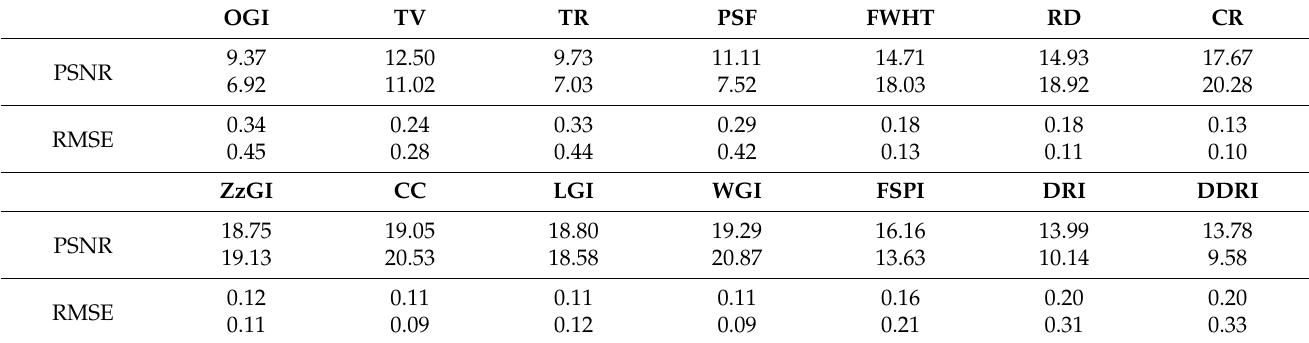
Table 5. PSNR and RMSE of images corresponding to Figure